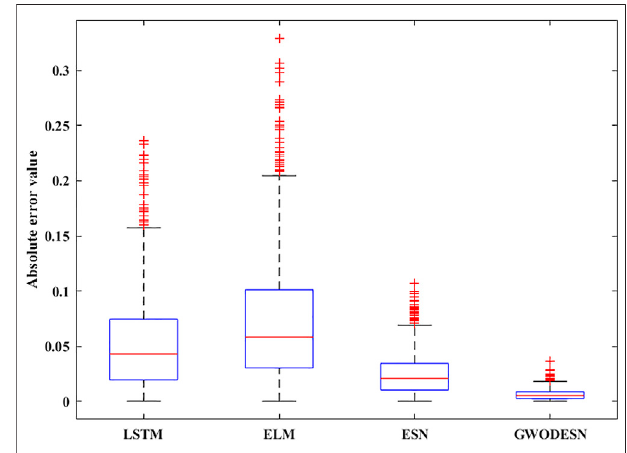
FIGURE 6 | The real value and the anticipated value for NARMA.